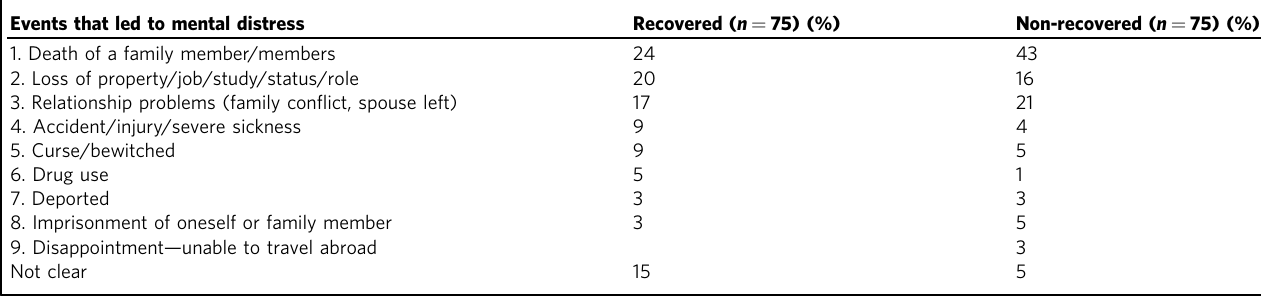
Table 2 Events that led to psychological